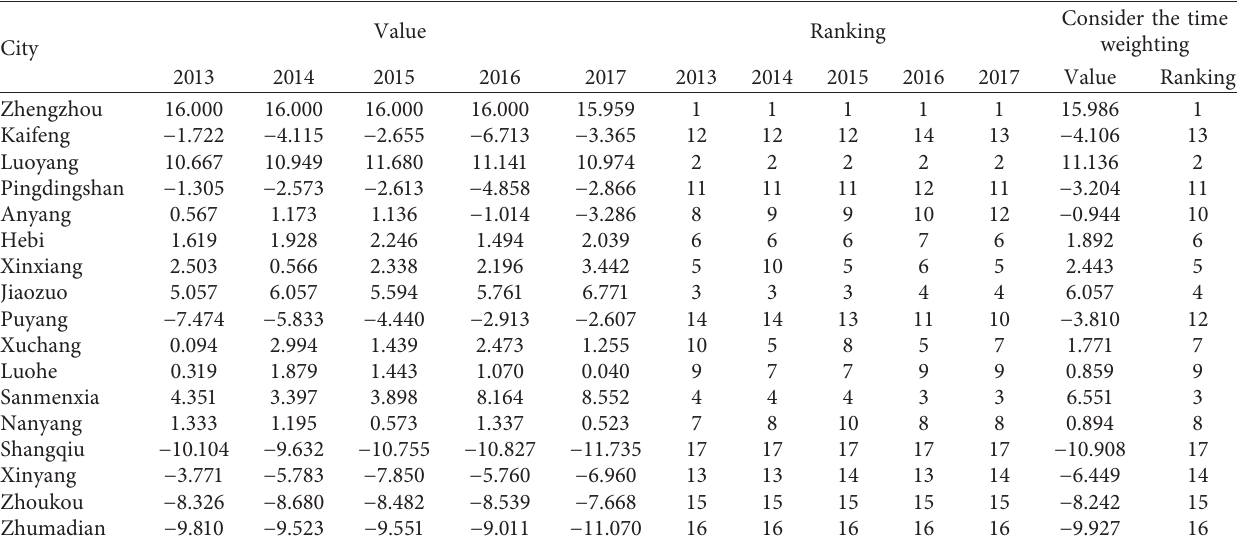
Consider the time